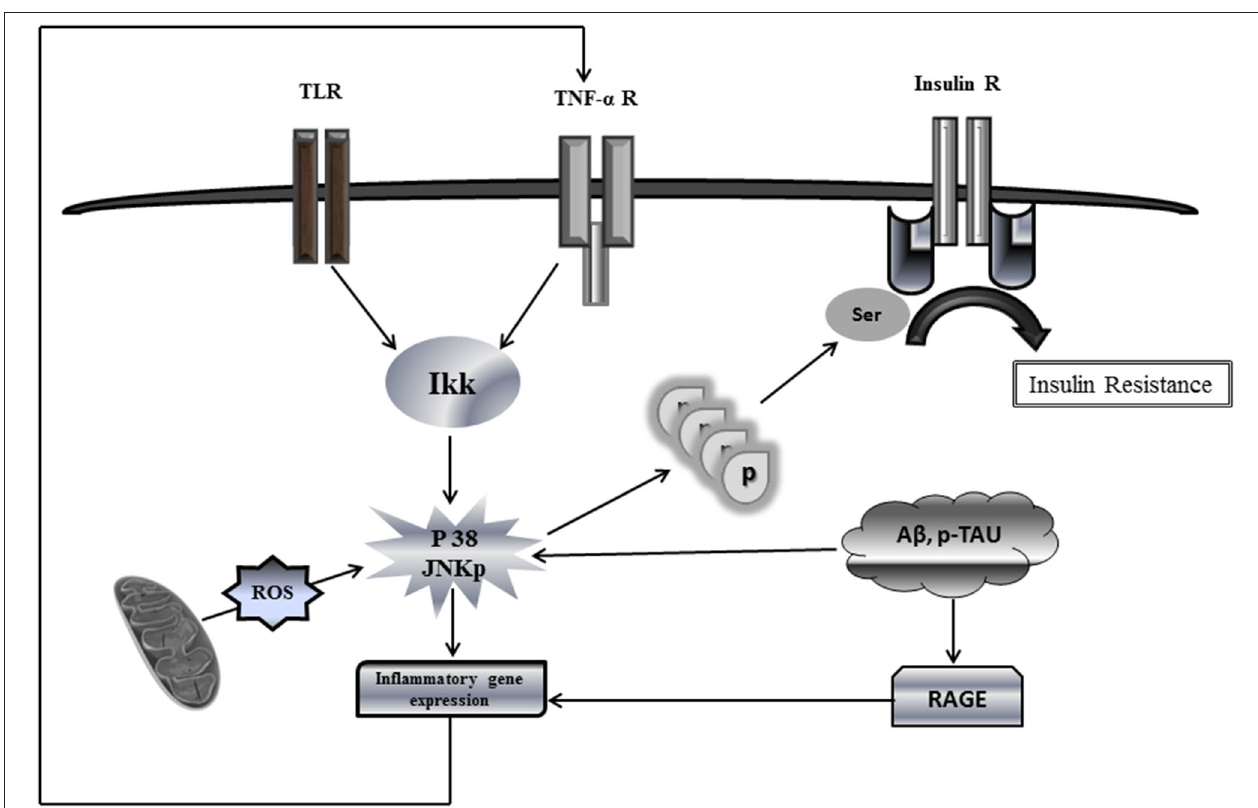
FIGURE 1 | Putative mechanistic model of insulin resistance via c-Jun N-terminal kinase (JNK) activation. This simplified putative model describes JNK activation pathway as a phosphorylation target of a variety of extracellular stimuli, e.g., proinflammatory cytokines as well as intracellular stimuli, oxidative stress, and oxidized mtDNA. Upon activation, phosphorylated JNK promotes direct serine phosphorylation of insulin receptor substrate protein IRS1, thus causing a defective IRS1 tyrosine phosphorylation and reduced phosphatidylinositide 3 kinase (PI3K) and AKT signaling in response to insulin receptor activation. Phosphorylation of serine residues inhibits the interaction of IRS1 with the insulin receptor, thereby blocking the response to insulin. Being applicable this model for neuronal IR would lead to disastrous consequences for most of the cellular stirpes within the brain. JNK activation by ROS-free radicals, A β , and hyperphosphorylated Tau promotes